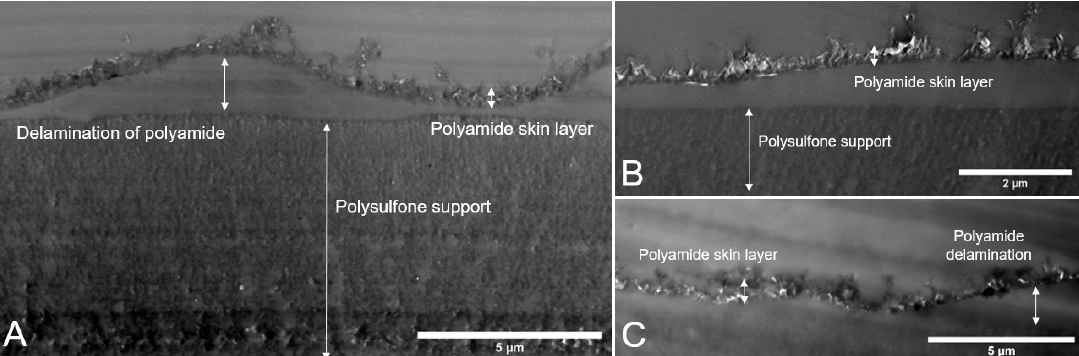
Figure 6. Cross-sectional TEM images of membranes fabricated via the vacuum filtration method: ( A ) plain polyamide TFC membrane; ( B ) TFN membrane with 0.5 mg of CNCs; and ( C ) and TFN membrane with 0.5 mg TOCNs. Delamination of the polyamide layer may be observed in all three samples, likely due to sample preparation conditions. Images were used to obtain thickness values for the polyamide layer in each case.